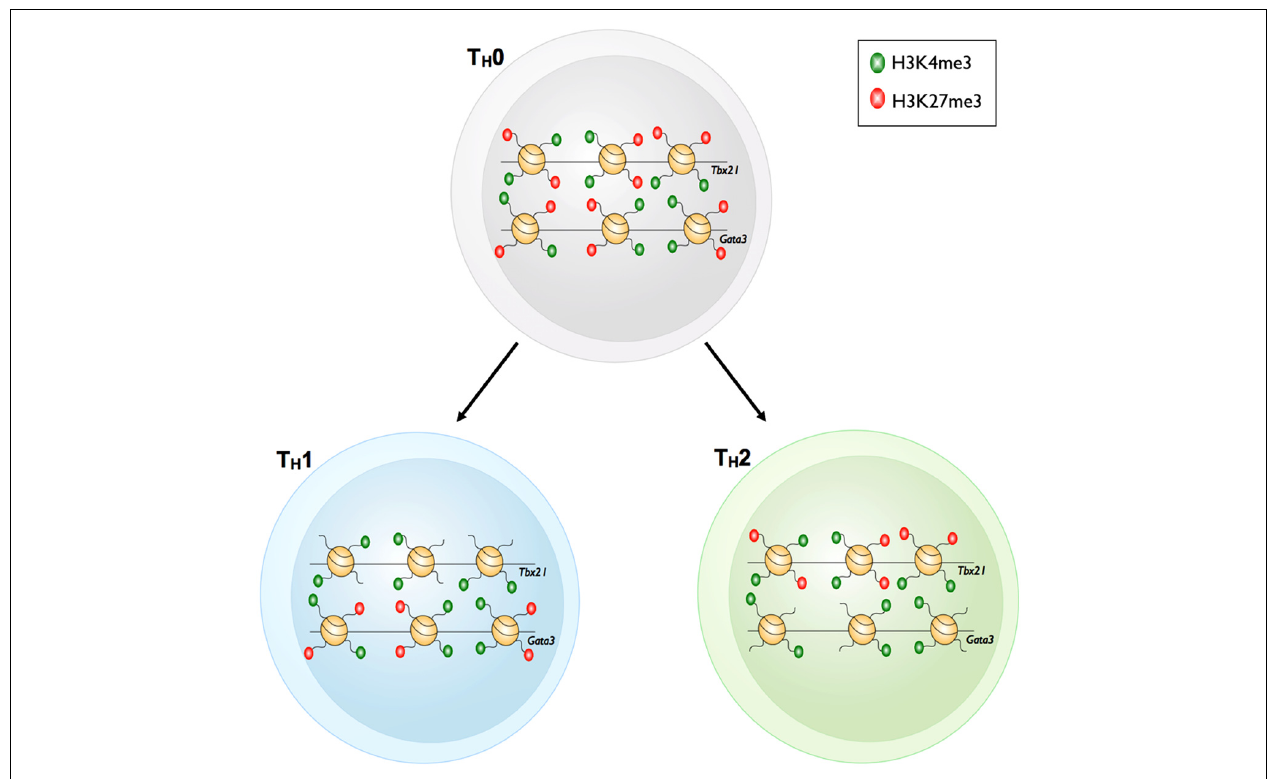
FIGURE 3 | Bivalency of master regulator gene loci inT H 1 andT H 2 cells . Prior to differentiation ofT H 0 cells into theT H 1 orT H 2 cell subsets, the master regulator loci of each subset, Tbx21 and Gata3 respectively, have both active H3K4me3 and repressive H3K27me3 marks.The bivalent Tbx21 locus